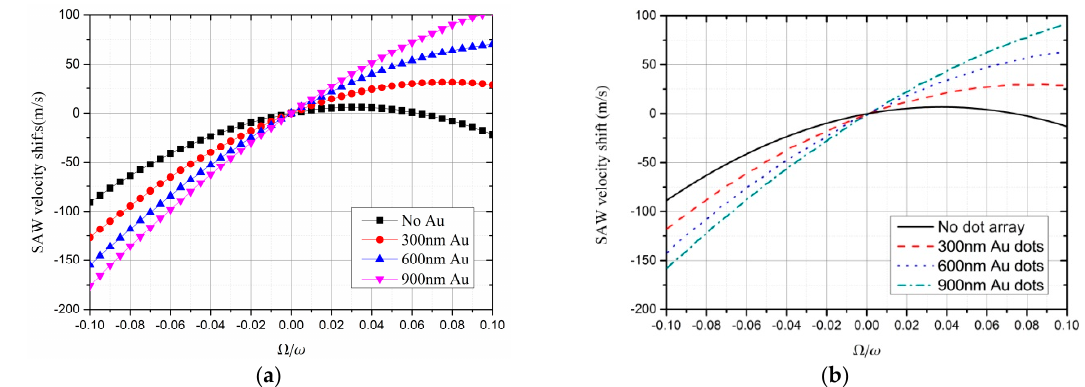
Figure 4. SAW velocity shift depending on Ω / ω under different Au thicknesses calculated by ( a ) FEM and ( b ) partial-wave method [1,14].